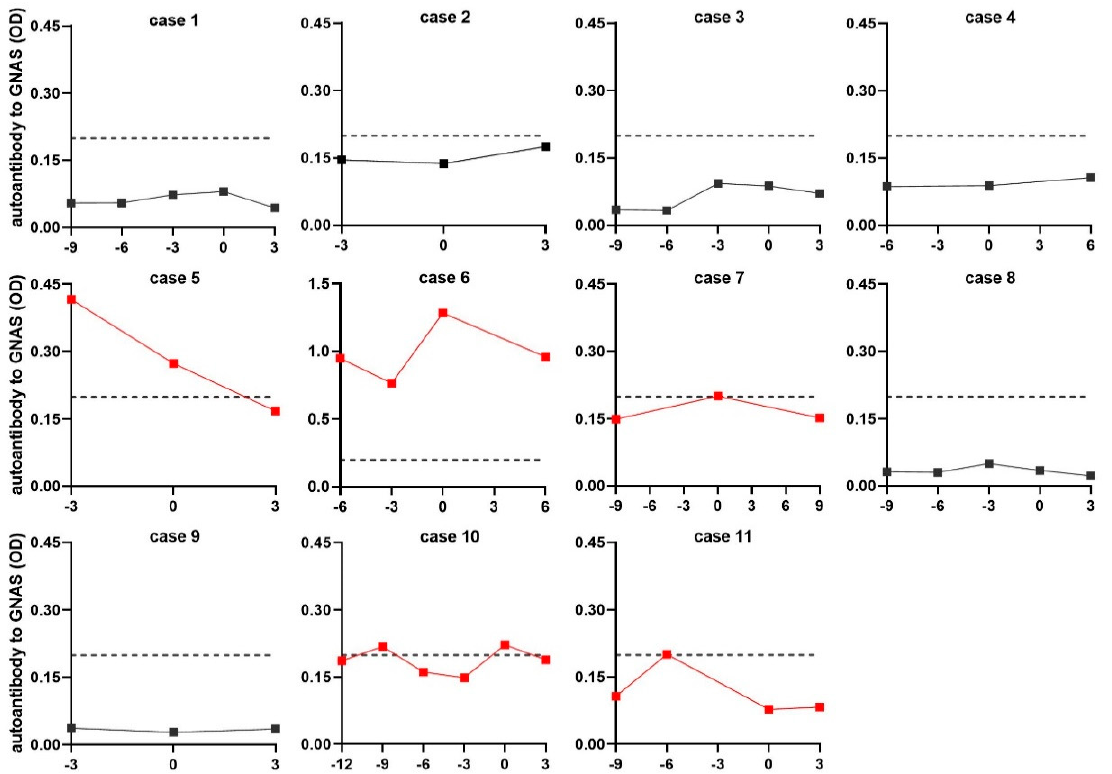
Figure 5. The level of autoantibody to GNAS in serial sera. The red lines refer to the serial sera with positive result from HCC patients before or at diagnosis of HCC. The vertical axis represents the OD value of autoantibody to GNAS, the horizontal axis represents the time frame (months) of serum sample collection. The “0” on the horizontal axis refers to the time the patient was diagnosed with HCC. Points to the left of “0” are the sera collected before diagnosis, points to the right of “0” are the sera collected after diagnosis. Each dot means each time node of serum sample collection. The dotted line parallel to the horizontal axis was cut-off lines (y = 0.199), which was determined by the 90th percentile of normal control.